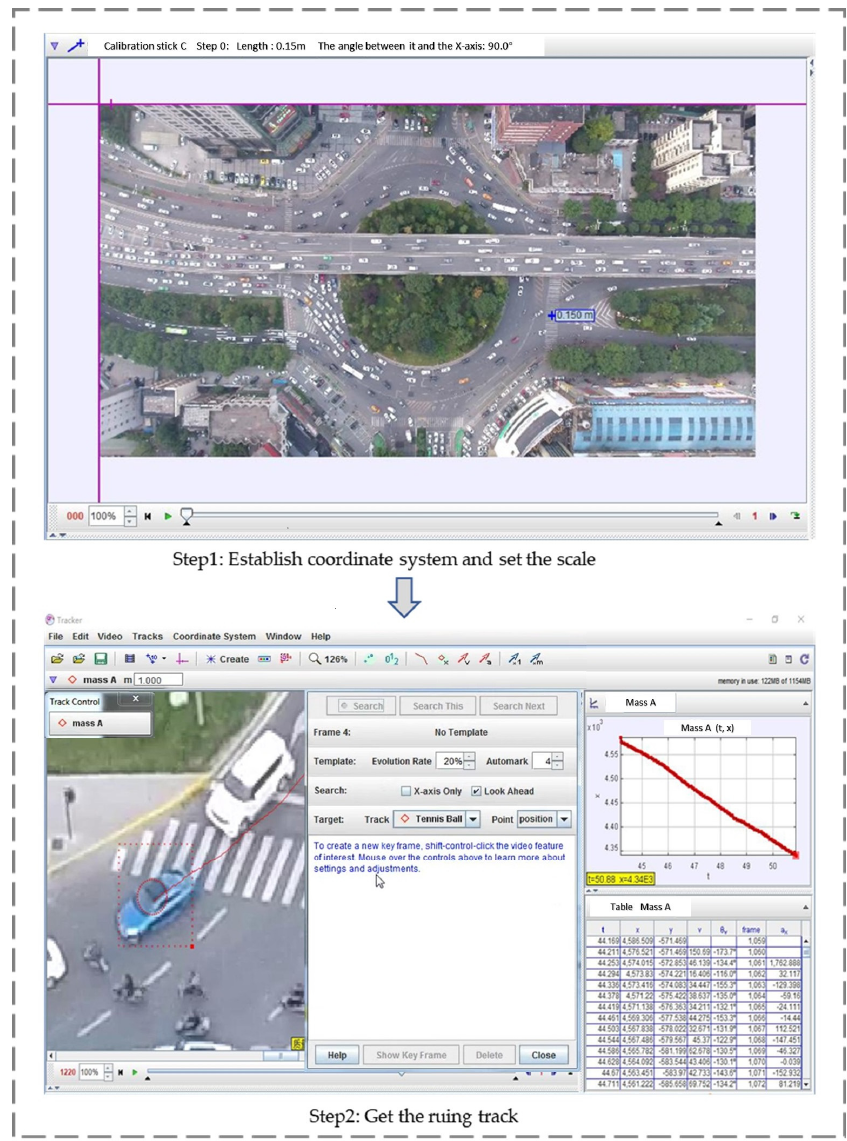
Figure 4. Trajectory extraction steps.